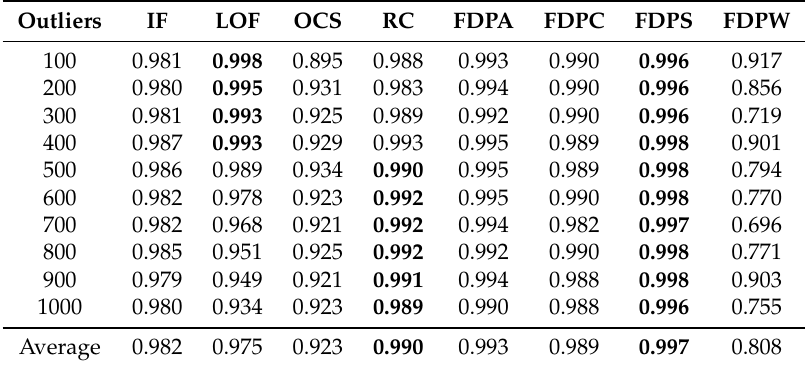
Table 6. The AUCs of the real-world datasets used in the experiments. The highest value of the FDP algorithms and the highest value of the comparison algorithms are respectively marked in bold